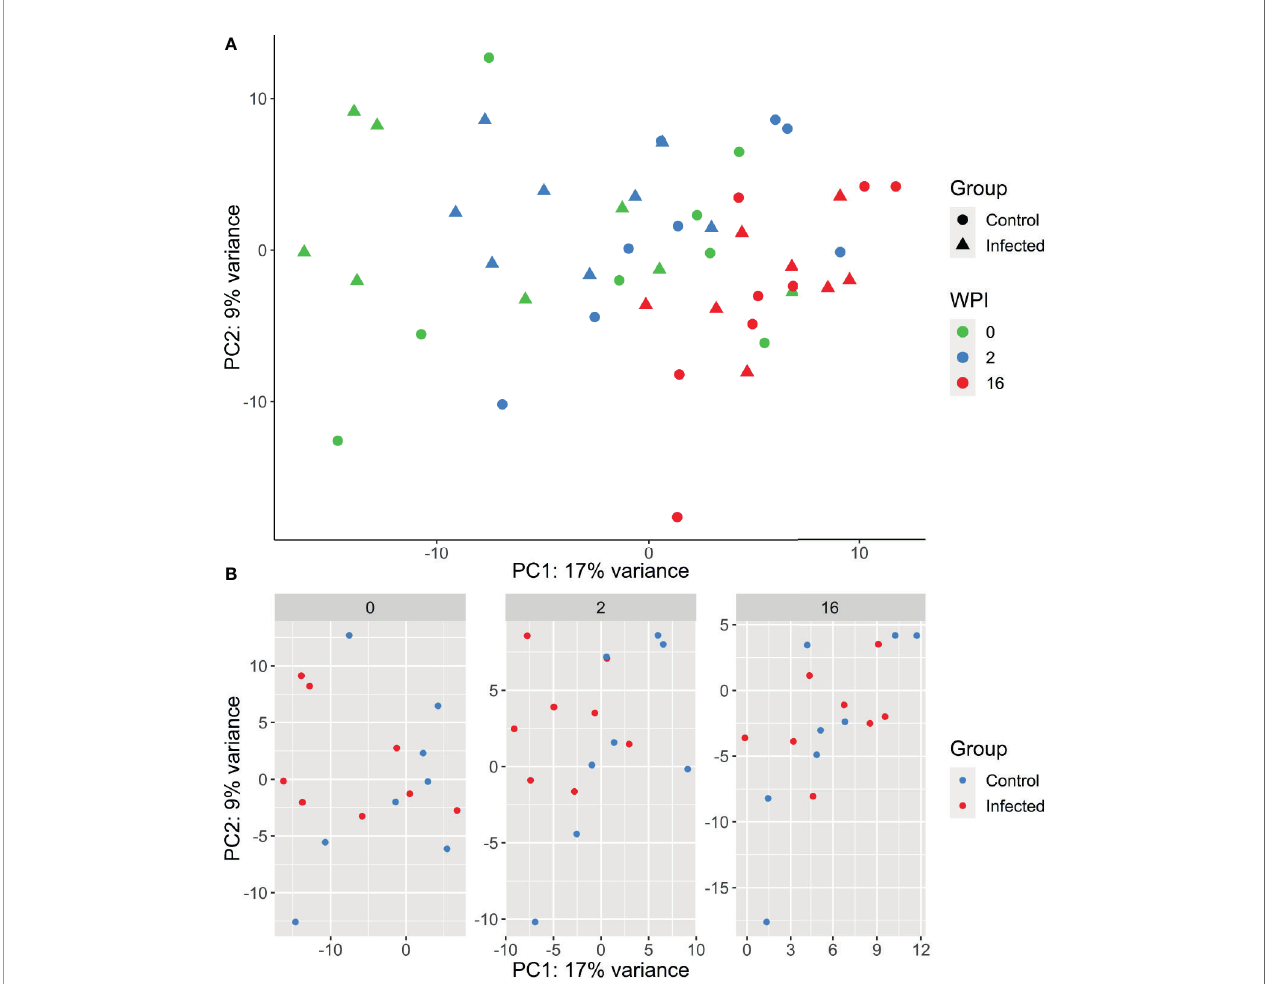
FIGURE 2 | (A) PCA plot generated from PBMC gene expression data of the 500 most variable genes following infection with F. hepatica in the infected (triangle) and control (circle) animals. Samples from each time point are represented by a different colour: 0 wpi - green, 2 wpi - blue, 16 wpi – red. WPI - weeks post infection. (B) PCA plots generated by time point, with infected animals in red and control animals in